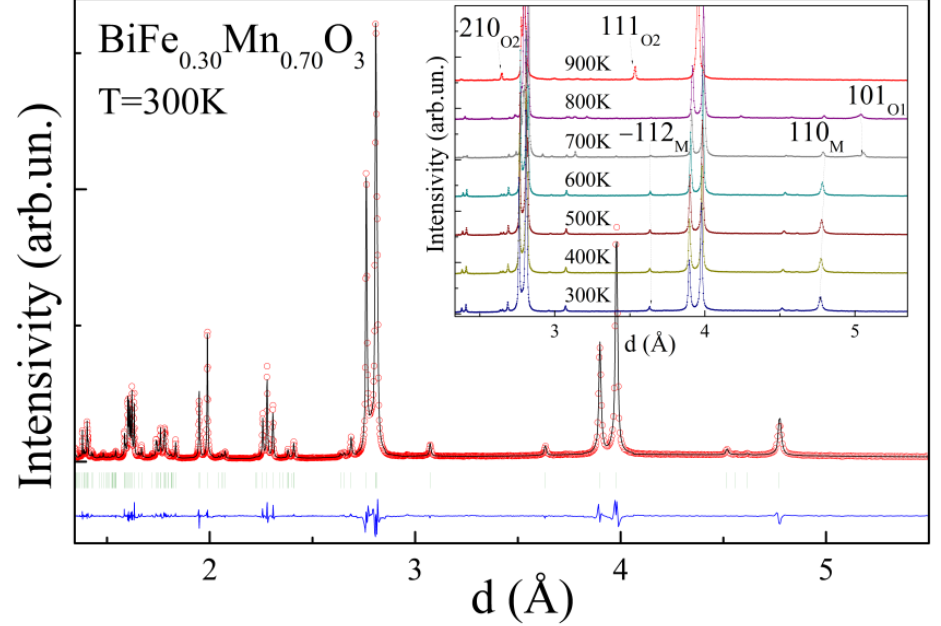
Figure 3. Room-temperature synchrotron diffraction pattern of BiFe 0.3 Mn 0.7 O 3 . The inset shows temperature evolution of the reflections attributed to the monoclinic and the orthorhombic phases (M— C2/c phase; O 2 — Pnma phase with metric √ 2a p ·4a p ·2 √ 2a p , a p —primitive perovskite unit cell parameter).